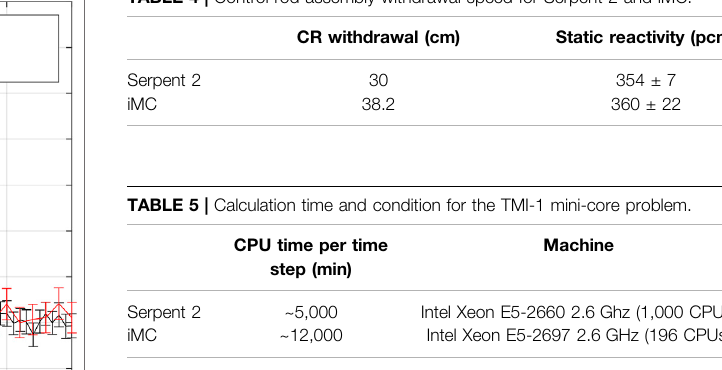
TABLE 4 | Control rod assembly withdrawal speed for Serpent 2 and iMC.